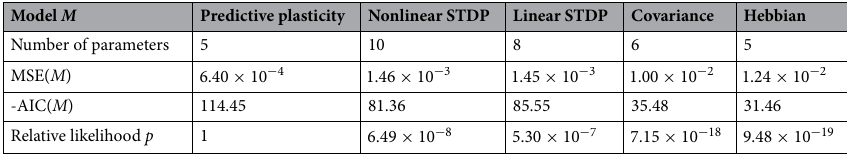
Table 1. Akaike information criterion supports predictive